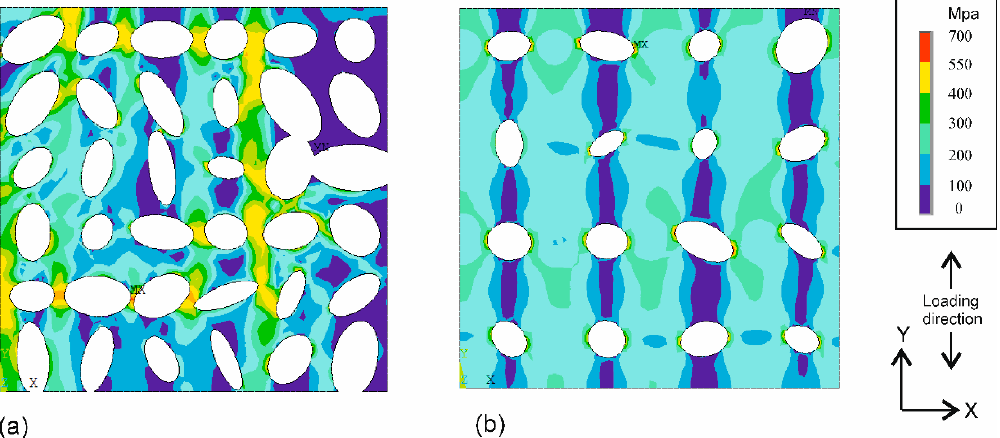
Figure 6. Von Mises stress distribution at 1% macroscopic strain, predicted by representative. FE models corresponding to ( a ) T s = 1000 °C, P c = 0 MPa, and ( b ) T s = 1300 °C, P c = 38.5 MPa.